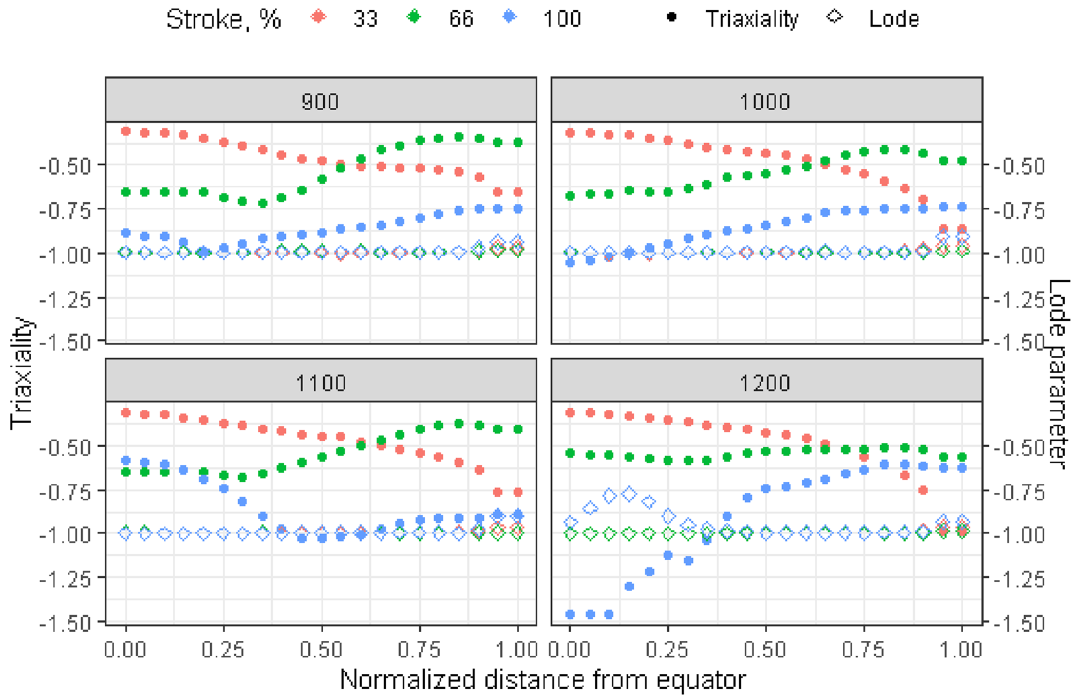
Fig. 14 Lode parameter and triaxiality factor for the axis line in three different compression stages for a nominal strain rate of 15